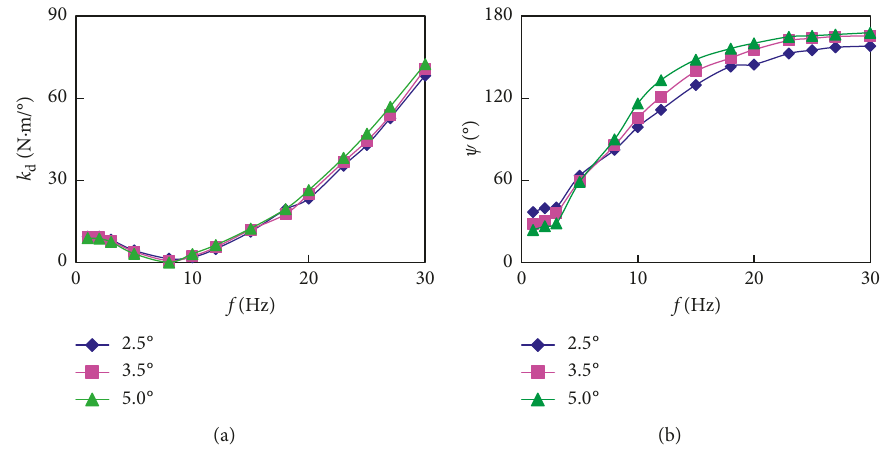
Figure 19: Different excitation amplitudes at